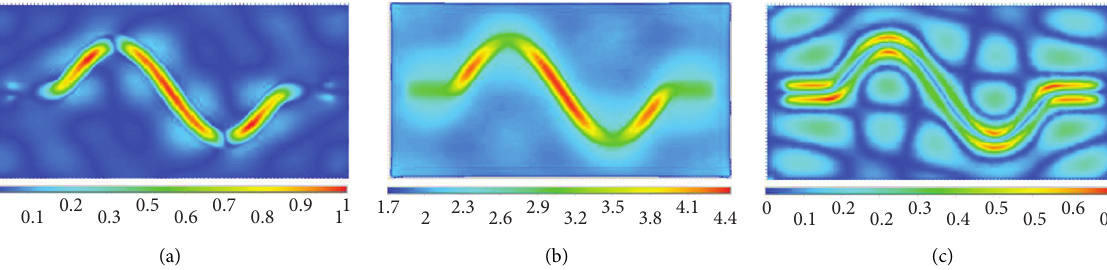
u u x , (b) y , and (c) z